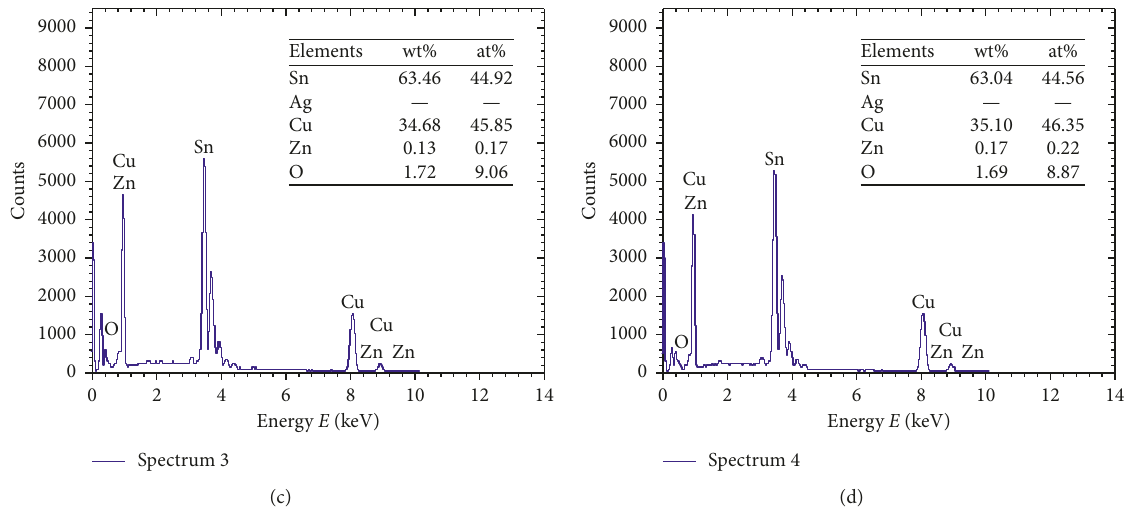
Figure 12: The EDS analysis of (a) Spectrum 1, (b) Spectrum 2, (c) Spectrum 3, and (d) Spectrum 4 of Figure 11.